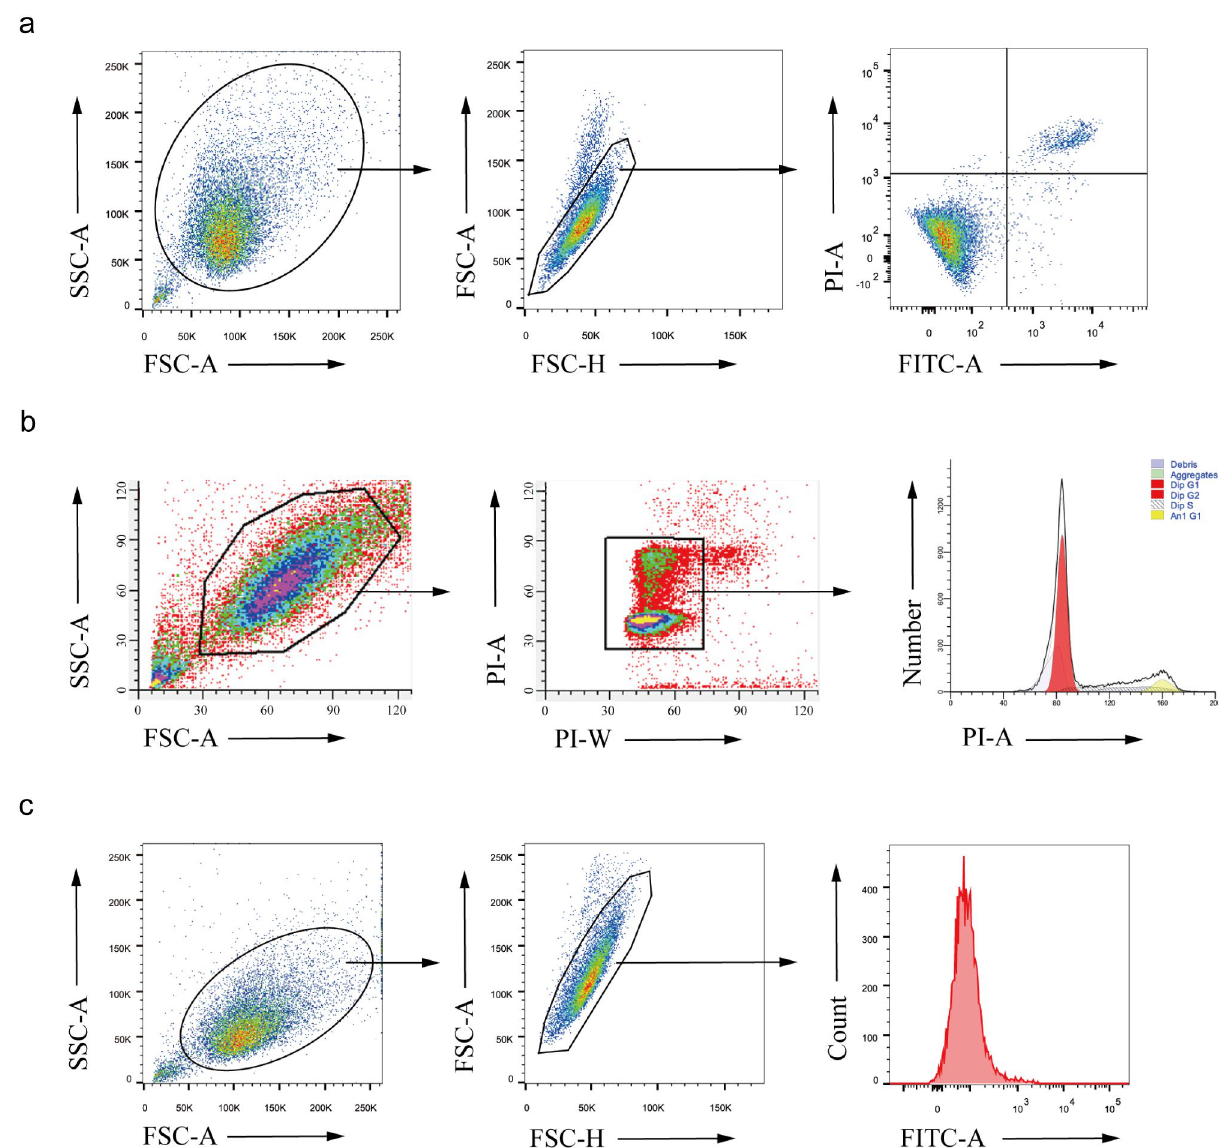
Figure A2. Flow cytometry gating strategy. ( a ) To determine cell apoptosis induced by PBP, cells were gated on FSC-A/SSC-A, FSC-H/FSC-A and then FITC-A/PI-A events to reduce the influence of cell debris and masses of dead cells. Viable cells, early apoptosis cells and late apoptosis cells were respectively defined as FITC-PI-, FITC+PI- and FITC+PI+; ( b ) Cells were gated on FSC-A/SSC-A and PI-W/PI-A events using Modfit LT software for cell cycle analysis; ( c ) Cells were gated on FSC-A/SSC-A and FSC-H/FSC-A events for ROS determination.